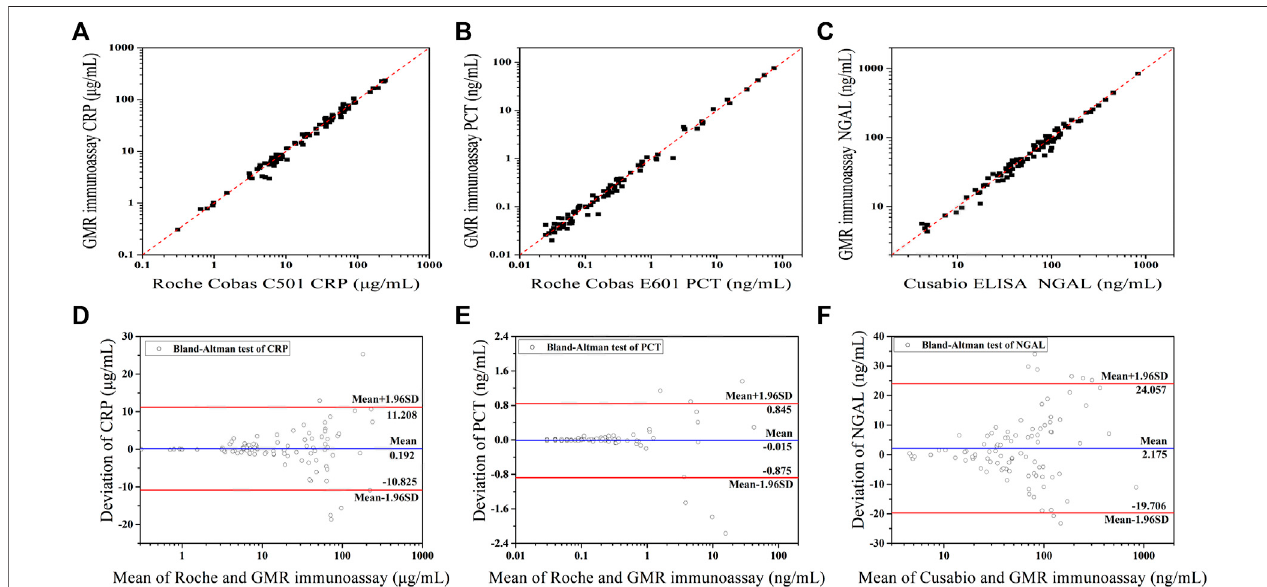
FIGURE 8 | Method comparison between two assays: fi tness analysis and Bland – Altman analysis of the agreement of CRP (A,D) (Adapted with permission from (Meng et al., 2021a) Copyright © 2021 Fanda Meng, etc. Published by American Chemical Society), PCT (B,E), and NGAL (C,F) detection between the GMR and commercialized